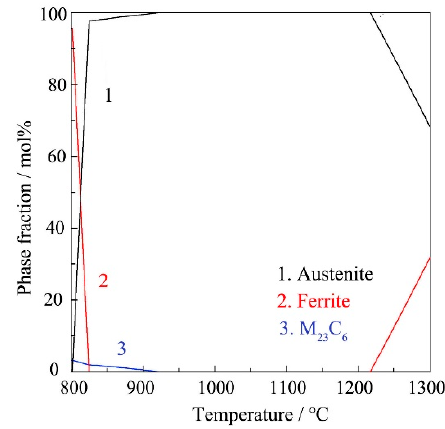
Figure 1. Phase diagram of the experimental steel calculated by Thermo-Calc.